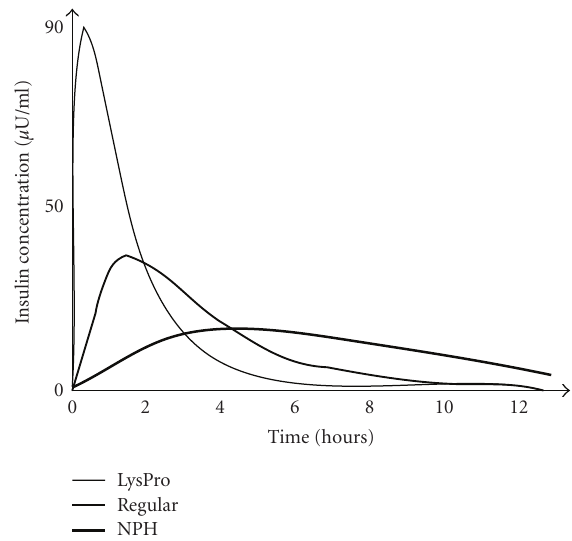
Figure 1: An example of insulin pump that integrates a blood glu- cose sensor [21]. Patient’s blood is sampled from the tip of his/her finger, and from the direct measurements of a blood glucose sensor, the amount of the short-acting insulin is adjusted and continuously delivered into the human